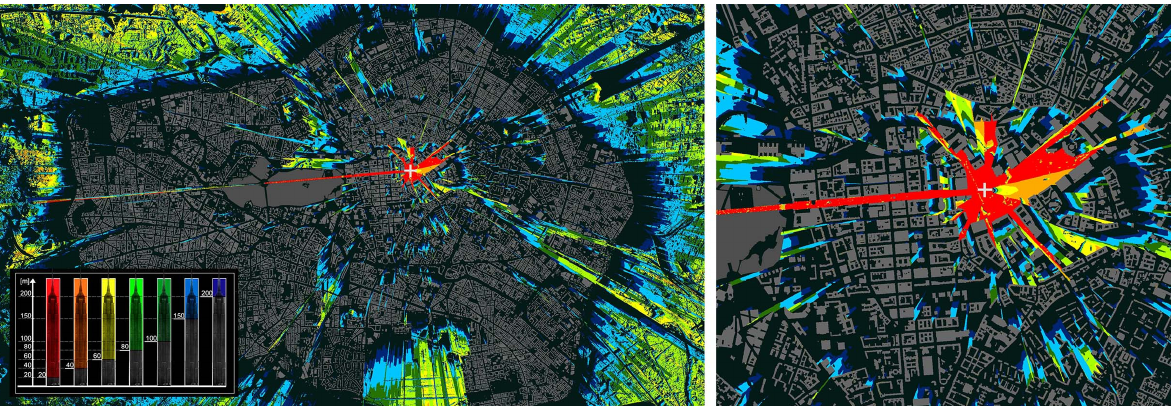
Figure 5. Analyses of Visual Impact Size (VIS) for tall building in center of Belin (a chart explains the results of analyses). Analysis was calculated on a basis of DSM model